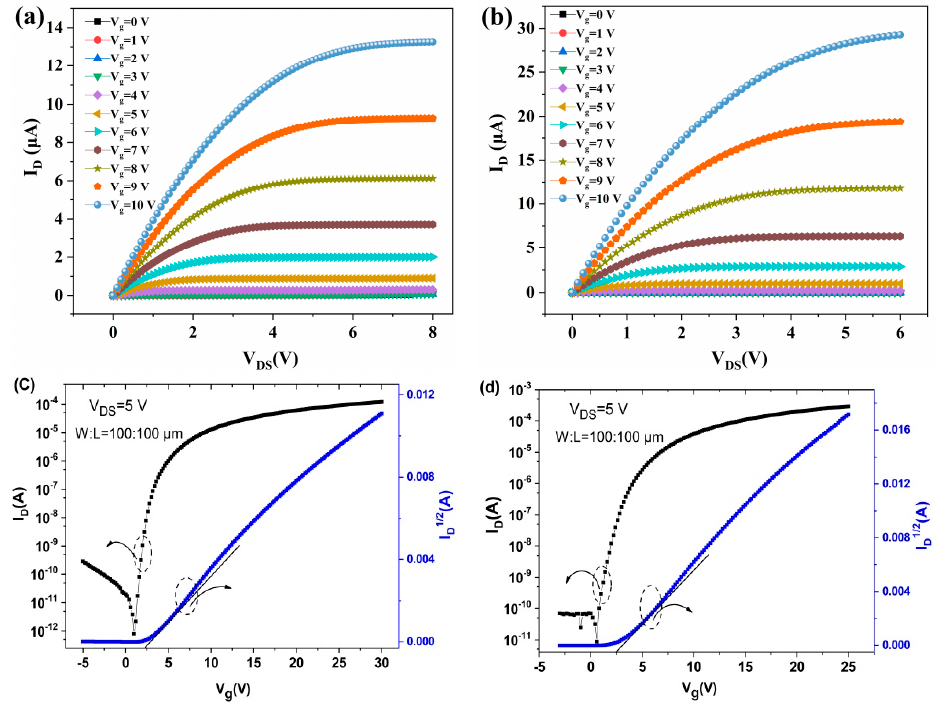
Figure 6. ( a , b ) Output characteristics of HS and SHS dielectrics-based a-IGZO TFT; ( c , d ) Transfer characteristics of HS and SHS dielectrics-based a-IGZO TFT. characteristics of HS and SHS dielectrics-based a-IGZO